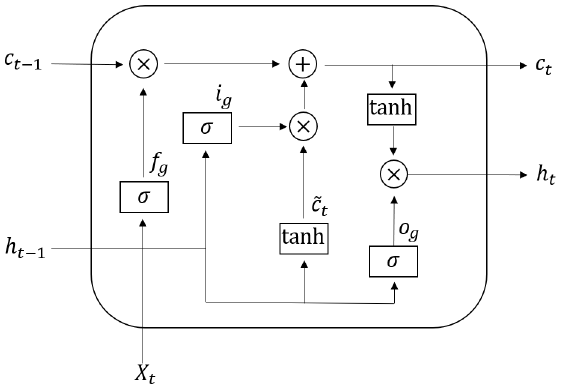
Figure 1. LSTM cell partially adapted from [32].